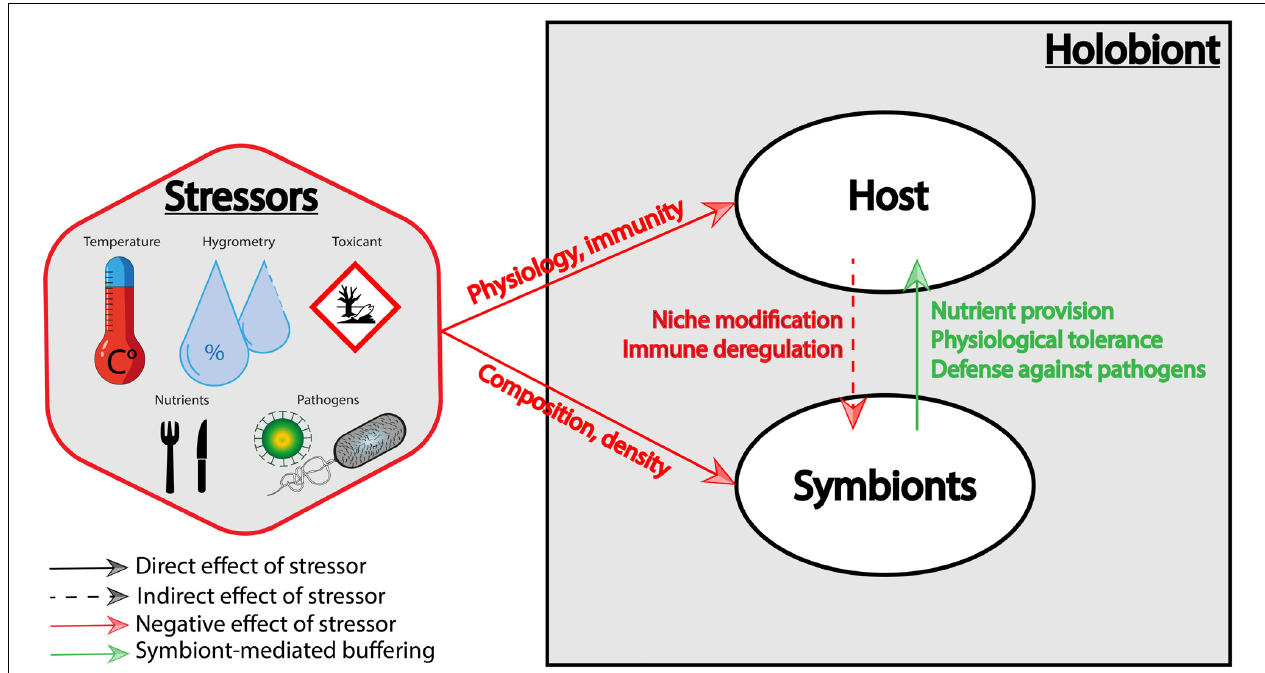
FIGURE 1 | Effects of stressors on the holobiont. Stressors can alter directly (1) the host physiology and immunity and (2) the symbiotic community composition and density. Stressors may also indirectly affect the symbiotic community by altering the host physiology (which represents the symbiotic niche), and the immune state of the host. Conversely, symbionts can buffer stressors via nutrient provision, physiological tolerance, and defense against host natural